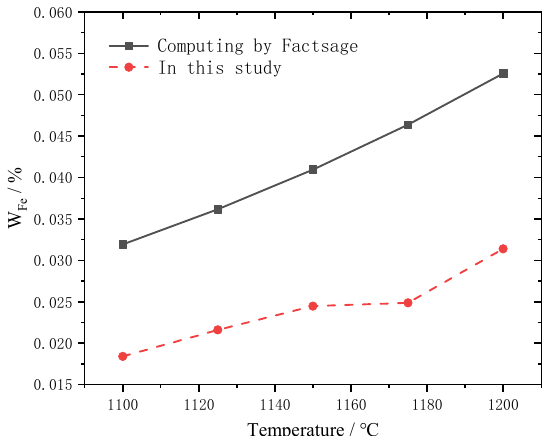
Figure 9. Theoretical content and test content of Fe in molten copper at different temperatures.